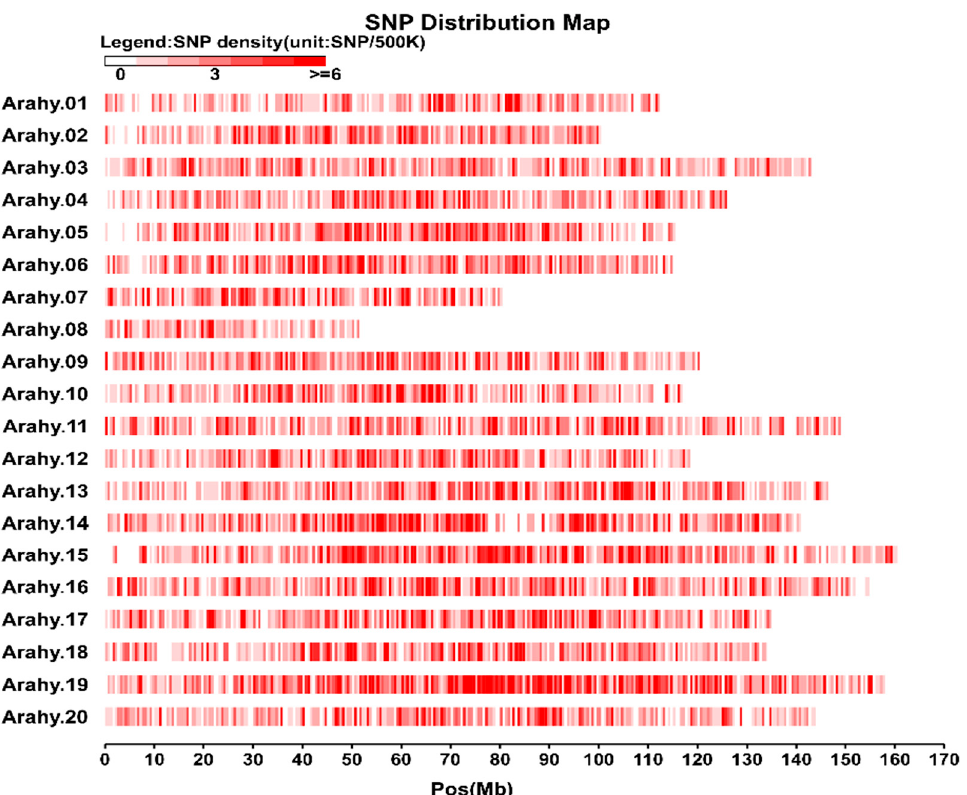
Figure 1. Single nucleotide polymorphisms (SNP) distribution in the 20 chromosomes of the cultivated peanut. The horizontal axis shows chromosome length (Mb), the shades of red represent SNP density (the number of SNPs per window). The vertical axis shows the 20 chromosomes.